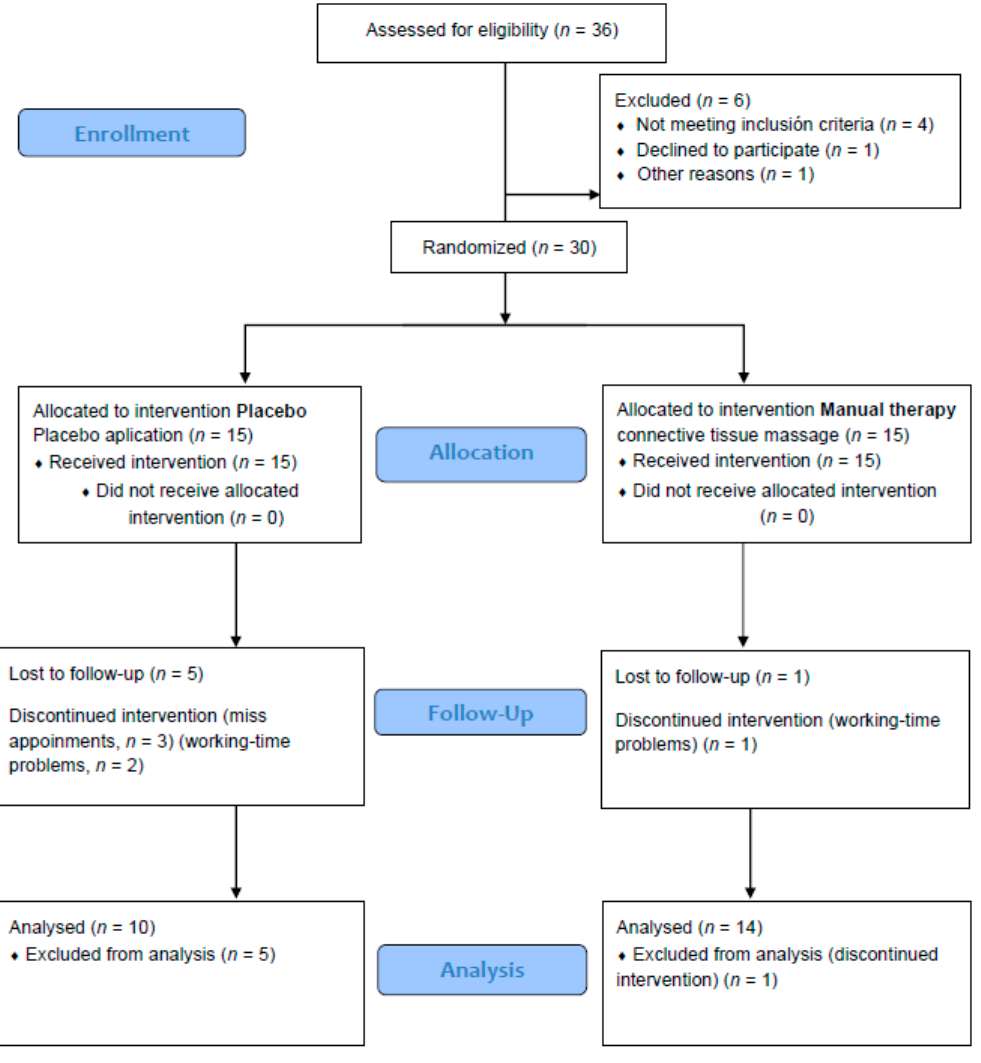
Figure 1. Consort 2010 flow diagram.